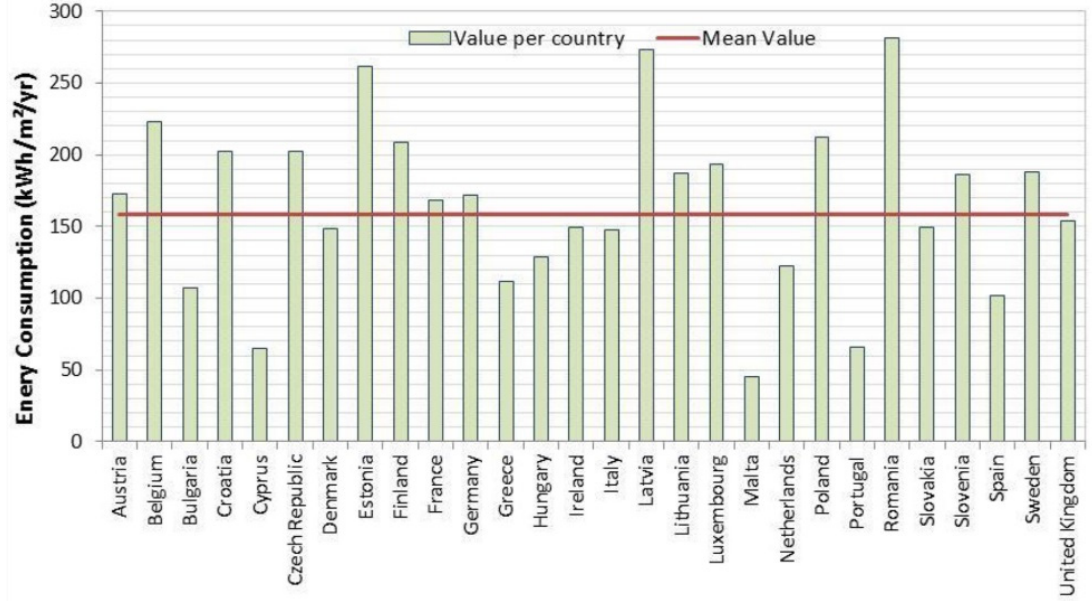
Figure 1. Annual energy consumption of buildings per m 2 on average [13].